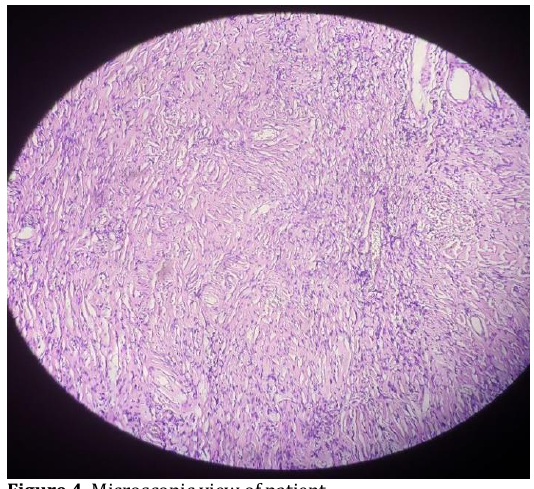
Figure 4. Microscopic view of patient lobular, homogenous, soft-tissue mass in the left lung (Figure